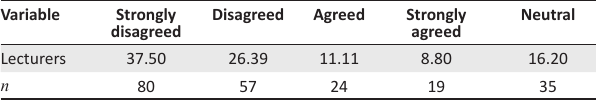
TABLE 4a: Does Knowledge of NC Facilitate the Learning of English?